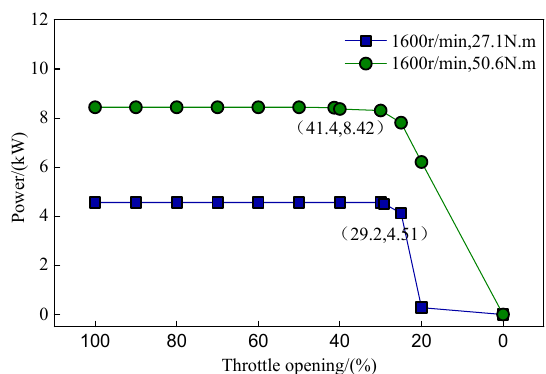
Figure 2. Power outputs with different throttle opening.